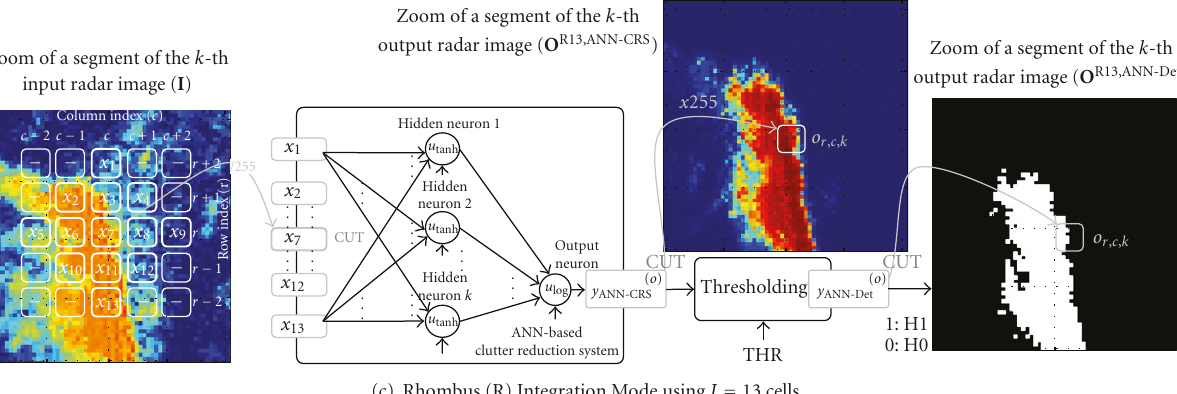
Figure 2: H, V, and R integration modes considering an RIA = 5 cells in the detection system based on ANN-based clutter reduction system.